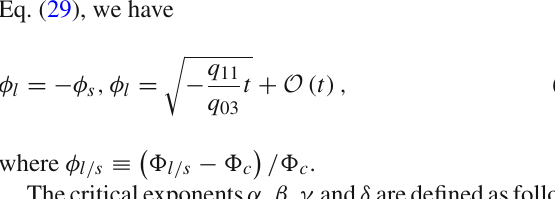
T = T p , and R = −∞ at T = T 1 and T 2 . The T - R diagram and the inset show that R is always negative. Right Column Q = 0 . 4 > Q c . There is only one black hole solution. As shown in the T - R diagram and the inset, R > 0 when the temperature is high enough or low